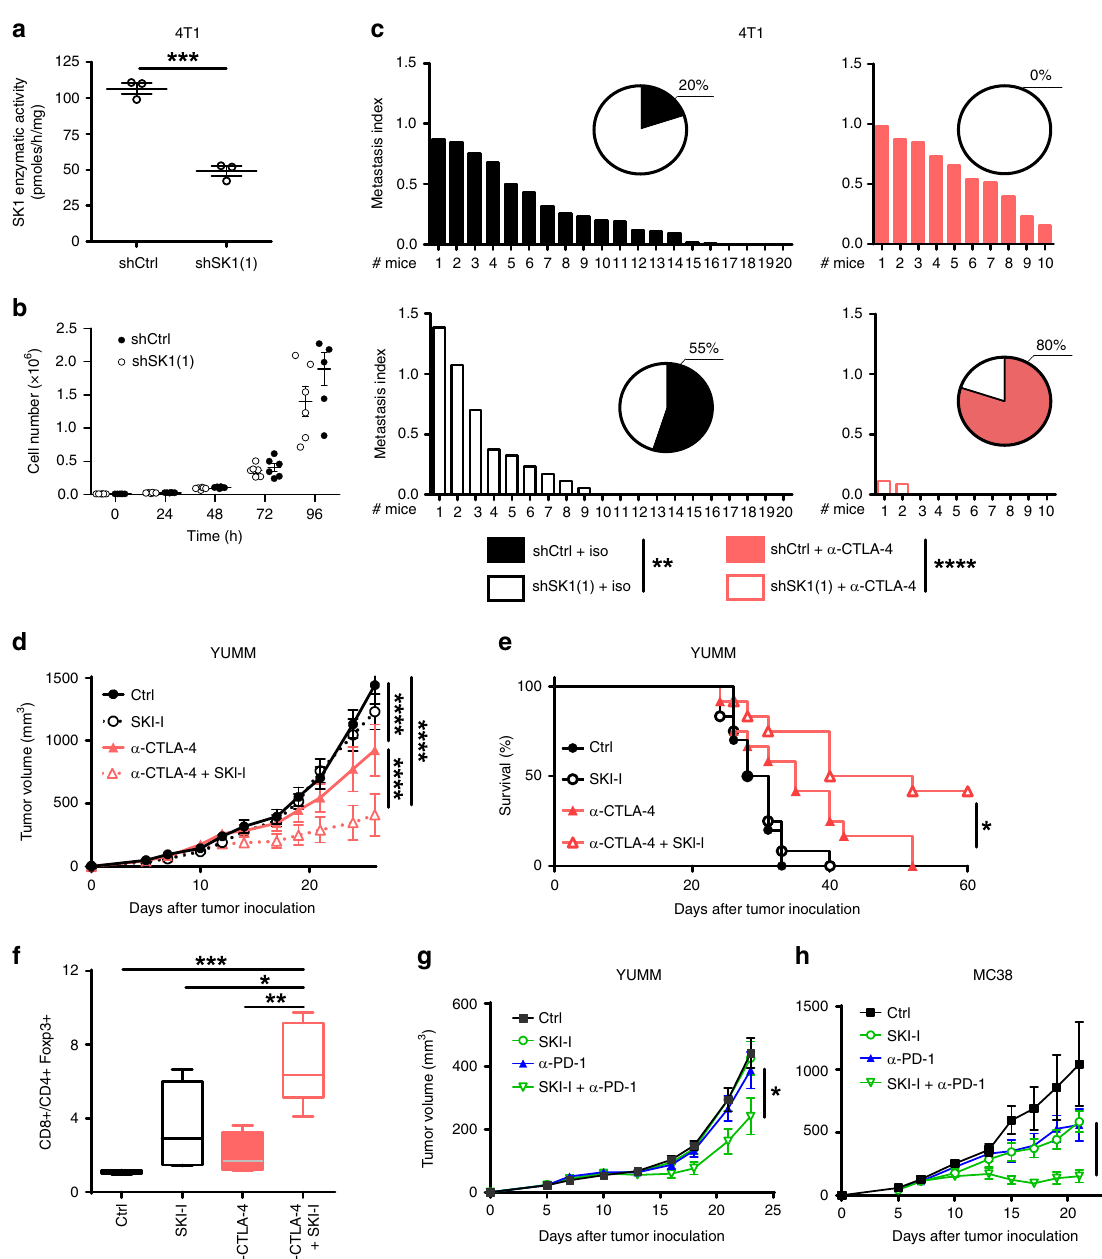
Fig. 5 SK1 targeting enhances ICI ef fi cacy in various cancer models. a SK1 enzymatic activity in 4T1-Luc cells stably transfected with a control shRNA (shCtrl;) or a SK1-targeted shRNA (shSK1(1)). Data are means ± SEM of three independent experiments. b Cell proliferation. Results are means ± SEM of four independent experiments. c shCtrl and shSK1(1) 4T1-Luc cells were injected in mammary fat pad of BALB/C mice. Mice were then treated with isotype control antibody (iso) or α -CTLA-4. Metastasis index at day 31 in lung of mice injected with shCtrl (upper panel; full columns) or shSK1(1) (lower panel; empty columns) 4T1-Luc tumors and treated (right panel; red columns) or not (left panel; black and white columns) with α -CTLA-4. Inserts: numbers indicate percentage of metastasis-free mice. Data are representative of two independent experiments. d – f Mice were challenged with untransfected Yumm cells and then treated or not with vehicle (Ctrl; black circles with black full line, n = 11 mice), SKI-I (white circles with black dotted line, n = 12 mice), anti- CTLA-4 (red and white triangles; full symbols with full line (without SKI-I n = 12 mice) or empty symbols with dotted line (with SKI-I n = 12 mice). Data are representative of two independent experiments. d Tumor volumes are presented as means± SEM. e Kaplan – Meier survival curves with log-rank test. f CD8/CD4 + Foxp3 + T-cell ratio in tumors at day 11 ( n = 4). g Mice were challenged with untransfected Yumm cells and then treated or not with vehicle (Ctrl; black squares with black line), SKI-I (empty green circles or triangles with green lines) and anti-PD-1 (full blue (without SKI-I) or empty green (with SKI-I) triangles) ( n = 12 mice/group). h Mice were inoculated with MC38 and then treated or not with vehicle (Ctrl; black squares with black line), SKI-I (empty green circles or triangles with green lines) and anti-PD-1 (full blue (without SKI-I) or empty green (with SKI-I) triangles) ( n = 5 mice /group). Data are representative of two independent experiments. Tumor volumes are presented as means ± SEM. Samples were compared using Mann – Whitney test ( a ) Kruskal – Wallis test with Dunn ’ s correction ( b , c , and f ) or using two ANOVA test ( d , g , and h